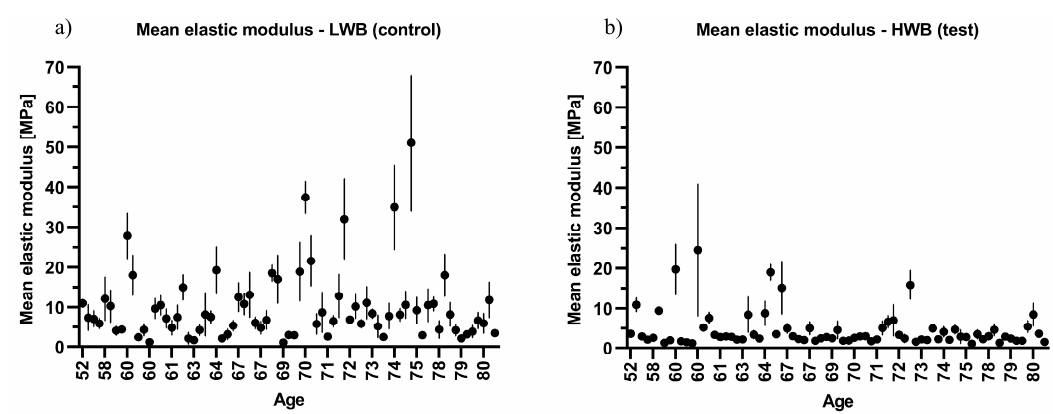
Figure 2. Scatter plot of the mean elastic modulus against age: ( a ) low weight bearing (LWB) sample and ( b ) high weight bearing (HWB) sample.